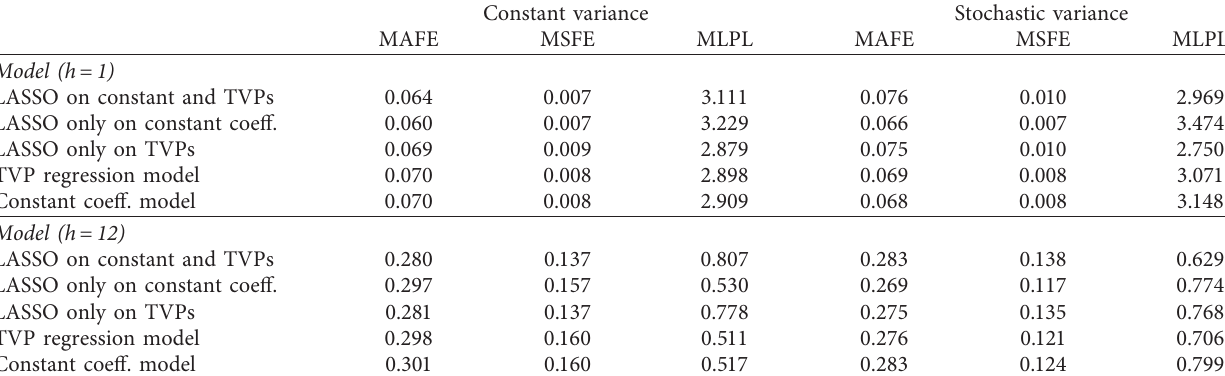
Table 9: Measures of forecast performance for log return of Brent ( h � 1) with UCSV